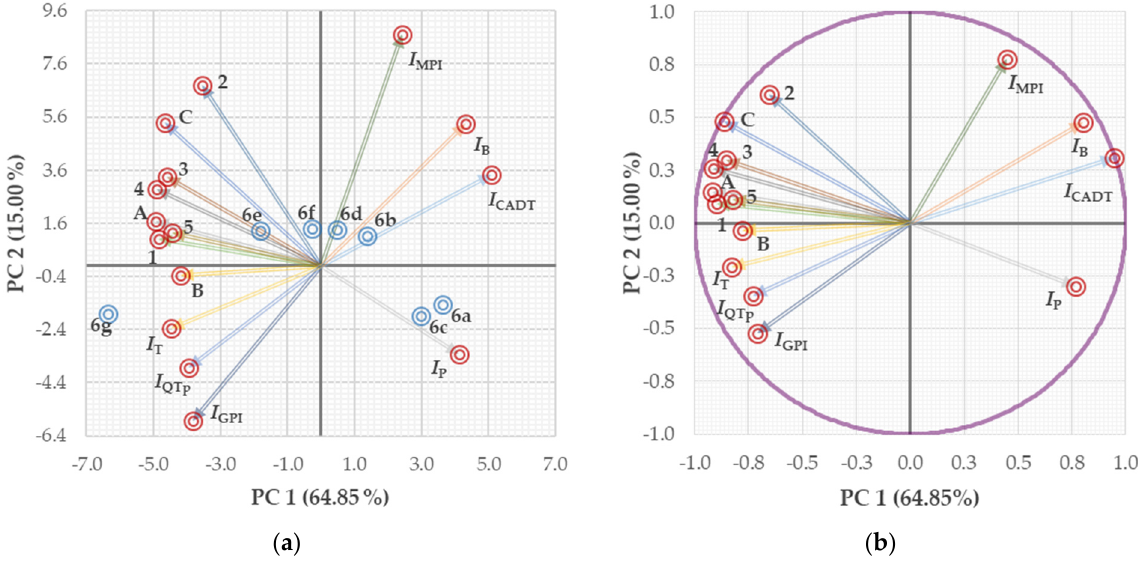
Figure 6. Graphical presentation of SARs for the 6a – g set: ( a ) two-dimensional (2D) score plot, which shows the (i) principal component 1 (PC 1) and 2 (PC 2) scores; (ii) loadings of particular variables; ( b ) 2D mapping of loadings of variables, which indicated their (i) positions within a circle of correlation; (ii) relationships with both PC 1 and PC 2. The labeling of analyzed variables was as follows: A (vector related to the m / z measured variable), B (log ε 2 (Ch–T) ), C (log k w ), I GPI (connected with the I GPI variable), I MPI ( I MPI ), I CADT ( I CADT ), I B ( I B ), I P ( I P ), I T ( I T ), I QTp ( I QTp ), and 1 (vector constructed on the log (1/MIC (M)) values. These MIC parameters resulted from the in vitro screening of 6a – g against Mtb H 37 R a ), 2 ( MK DSM), 3 ( MS ), 4 ( MM ), and 5 (vector constructed on the log (1/IC 50 (M)) values. These IC 50 values resulted from the in vitro screening of 6a – g against